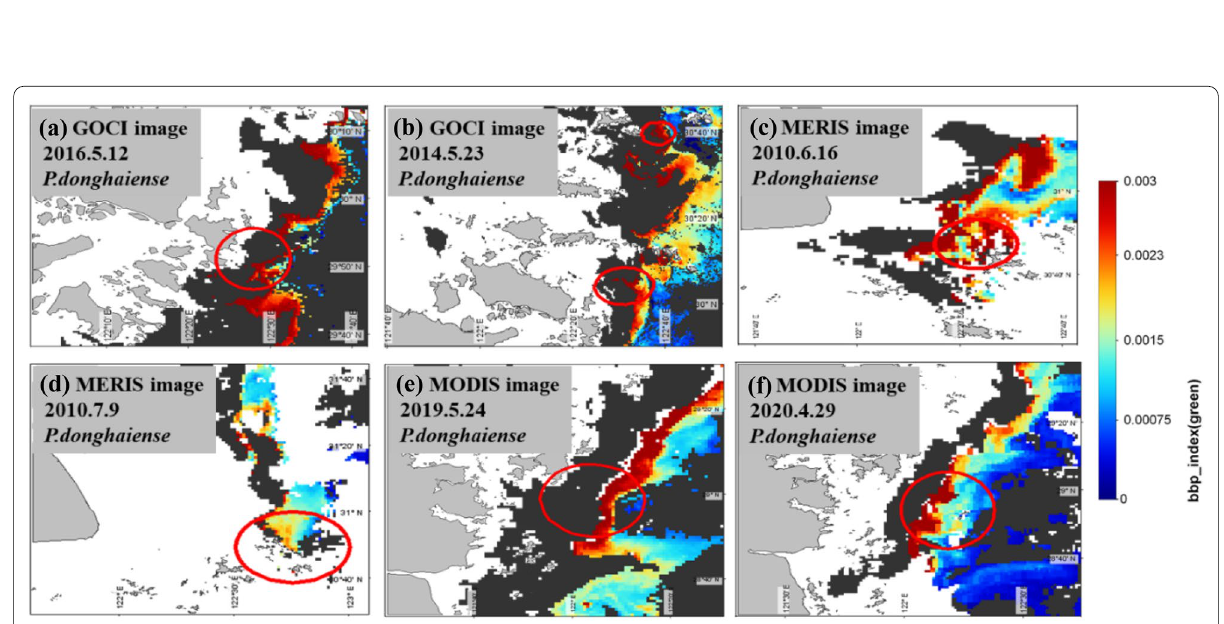
( green ) of Prorocentrum donghaiense blooms water from 2004 to 2020. a , b b bp_ Fig. 3 Satellite imagery derived b bp _ index ( green ) map derived by MERIS images. e , f b bp_ ( green ) map derived by MODIS images. The highlighted regions (red GOCI images. c , d b bp_ index index circles) indicate occurrences of Prorocentrum donghaiense blooms that were recorded by the SOA and the Bulletin of China Marine Disaster from the ( green ) . The black pixels indicate area of non-bloom Zhejiang Ocean Forecast. The color bar represents the variation of b bp_ index